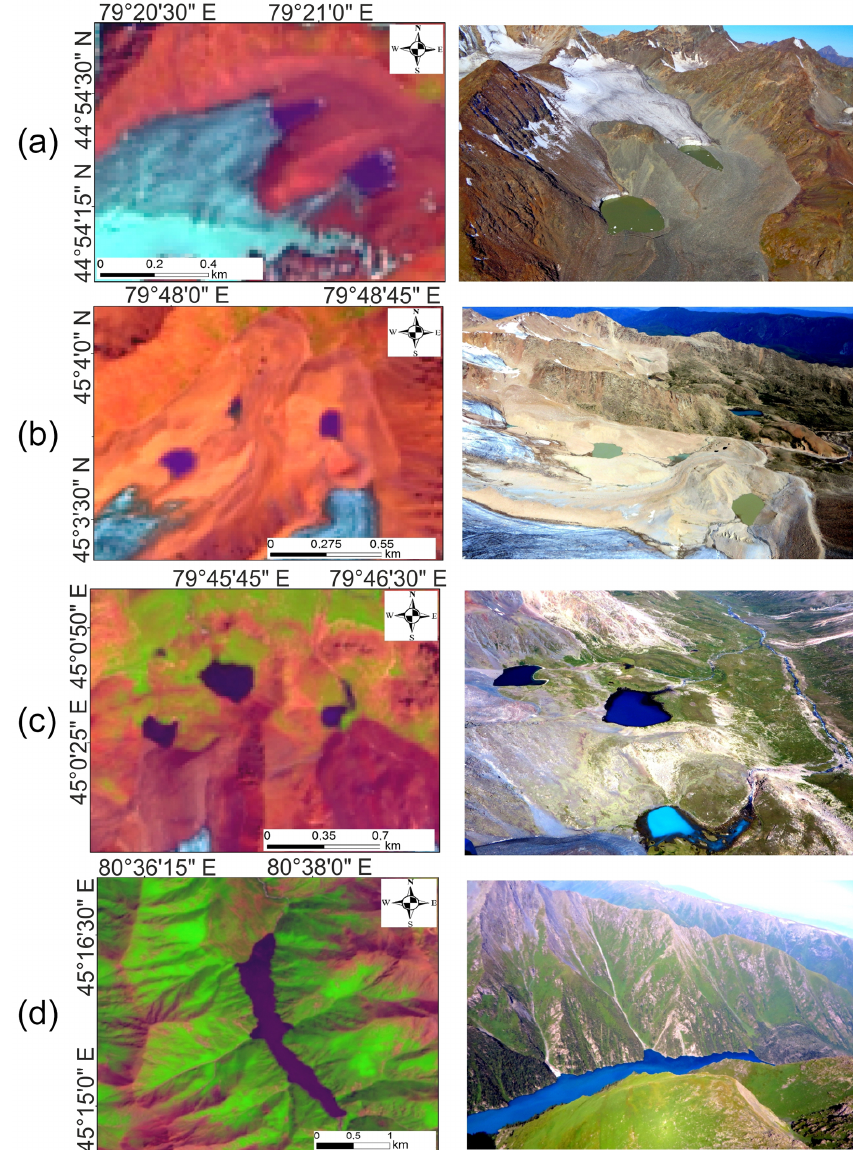
Figure 4. Examples of lakes of different types: Landsat imagery (2014) and oblique aerial photographs (V. Kapitsa; M. Kasenov; July 2014): (a) Type 1 (contact lakes); (b) Type 2 (proglacial lakes on 20th to 21st century moraines); (c) Type 3 (proglacial lakes on LIA and older moraines); (d) Type 4 (rock-dammed